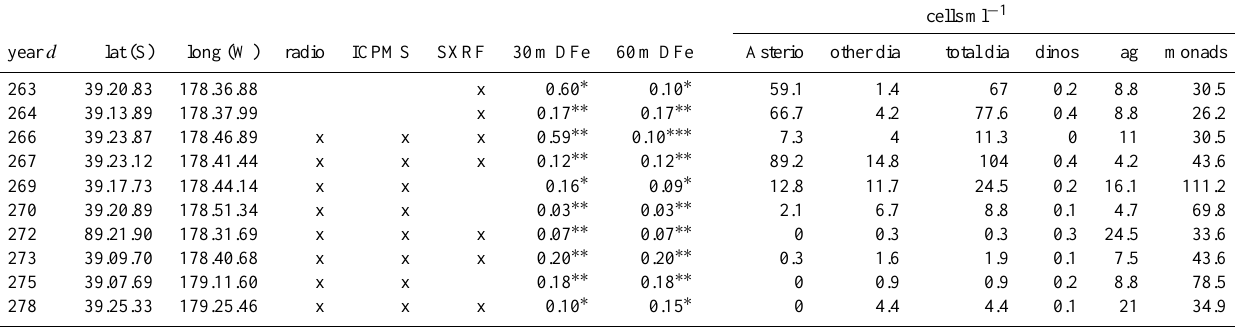
∗ DFe values from trace metal clean rosette, collected 30min prior to samples collected for Fe quotas. ∗∗ DFe values from trace metal clean fish, collected ∼ 12h after samples collected for Fe